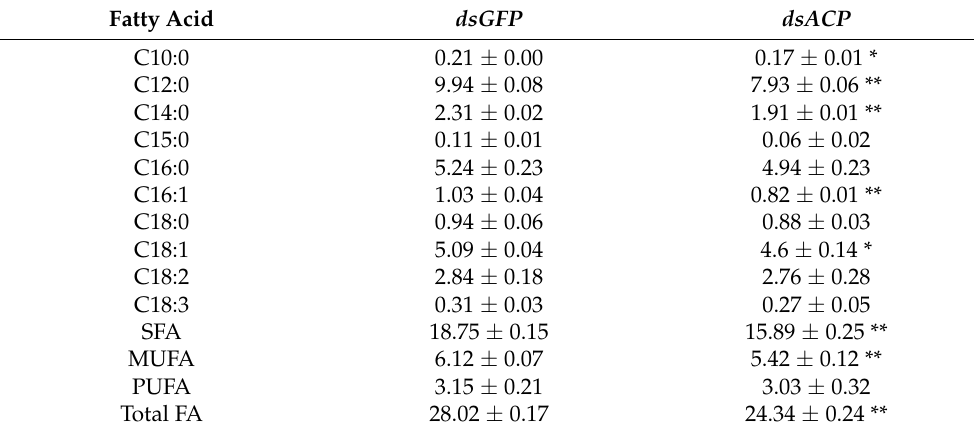
Figure 3. Relative transcript levels of HiACP after injection of 1.5 µ L dsACP in one-day-old 3rd instar larvae with different concentrations and different days. ( A ): Relative transcript levels of HiACP 48 h after injection of 1.5 µ L dsACP in one-day-old 3rd instar larvae with different concentrations. The larvae injected with dsACP were collected at 48 h. ( B ): Relative transcript levels of HiACP after 1.5 µ L (2000 µ g · mL − 1 ) dsACP injection in 3rd instar larvae. The transcript level of HiACP was analyzed by qRT-PCR. Mean ± SE was calculated from five biological replicates, and each biological replicate contained ten 3rd instar larvae. Bars marked with different letters indicate significant differences between treatment and control (Student’s t -test, p < 0.05). Table 2. Fatty acid composition (g/100 g) of 3rd instar larvae after dsACP